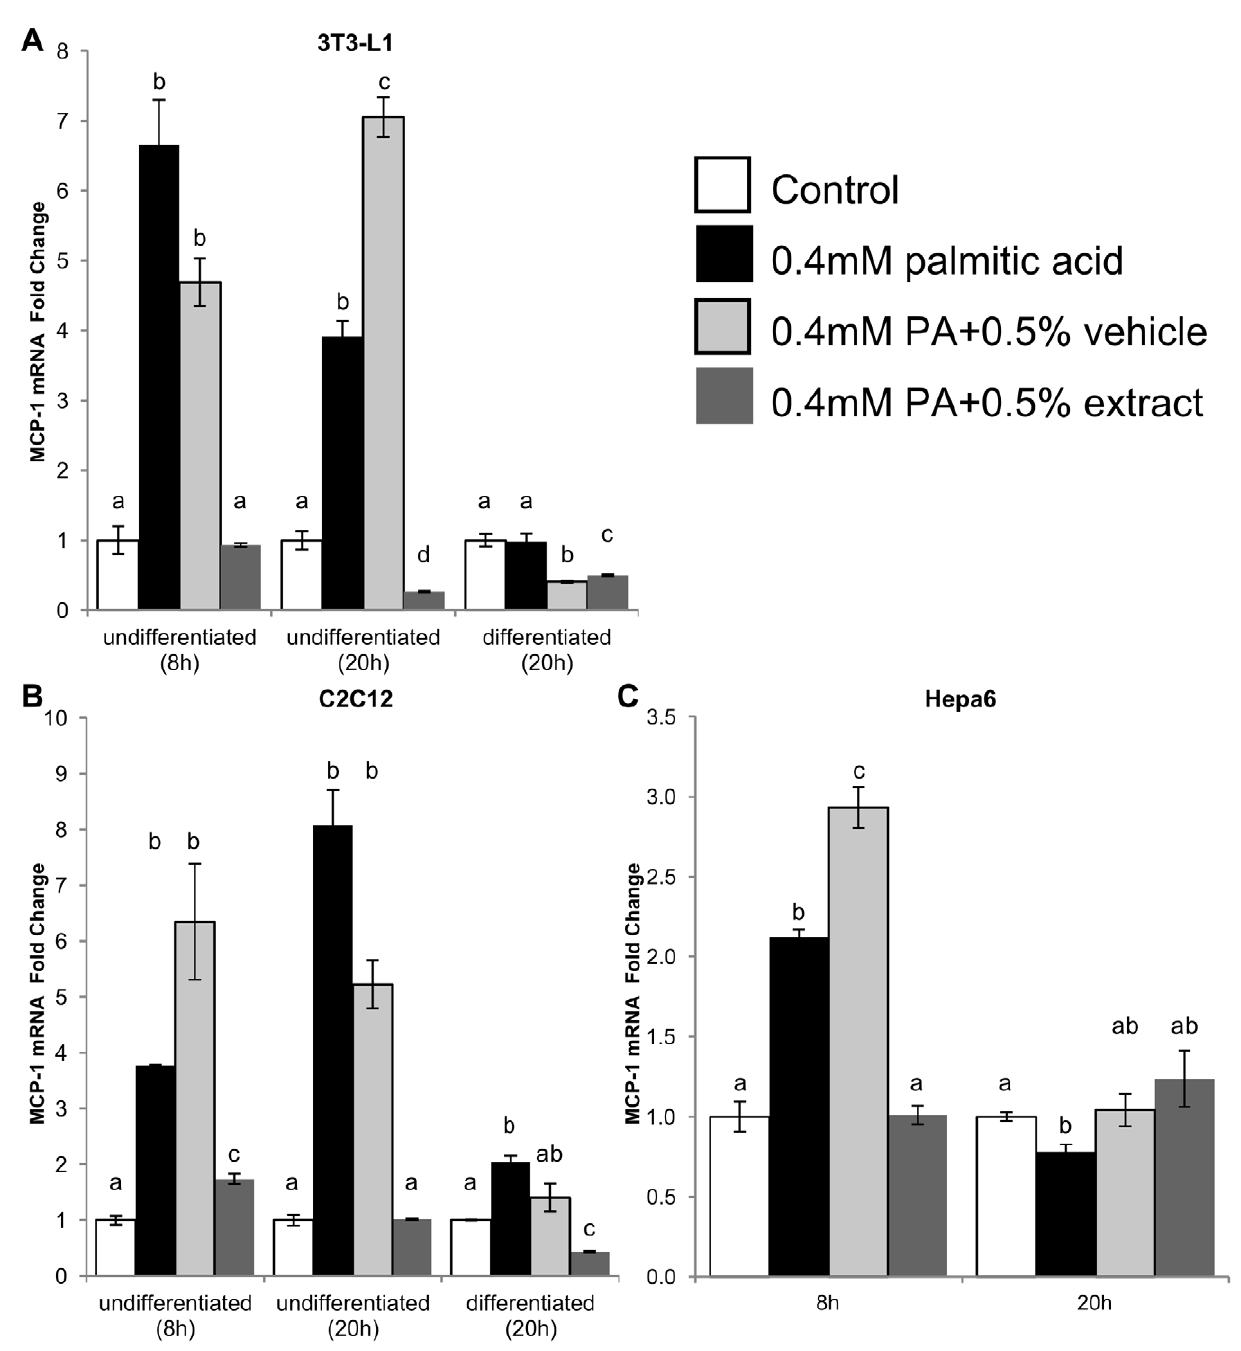
Figure 1. Effect of BEX on MCP-1 mRNA expression. Levels of MCP-1 mRNA expression in 3T3-L1 (A), C2C12 (B), and Hepa6 (C) murine cells in response to palmitic acid (PA, 0.4 mM) in combination with BEX (125 m g/ml or 0.5%, v/v) or ethanol vehicle (0.5%, v/v) at different time points and differentiation states (3T3-L1 and C2C12). Fold change calculated via comparative cycle threshold ( 2 DD Ct) normalized to beta-glucuronidase (GUS b ). Other housekeeping genes such as 18 S ribosomal RNA (18 S), hypoxanthine-guanine phosphoribosyltransferase (HPRT), and glyceraldehyde 3- phosphate dehydrogenase (GAPDH) were also used and yielded similar results as GUS b . Mean 6 standard deviation of at least 4 qRT-PCRs per cell type. Mean results were compared between treatments of the same cell type and at the same time point. Differences between means are statistically significant if columns do not share any common letters (p , 0.05, one-way ANOVA with Tukey’s multiple comparison test). doi:10.1371/journal.pone.0045082.g001 PA increased nuclear concentrations of NF- k B subunits RelA BEX, as 3T3-L1 cells simulate cellular components in adipose (p65) and p50 in 3T3-L1 cells after 2 hours, although this effect which are highly active in obesity-associated chronic inflammation was only significant for RelA (Figures 4A, 4B). At that time, [49]. ethanol controls did not affect NF- k B subunit nuclear transloca-